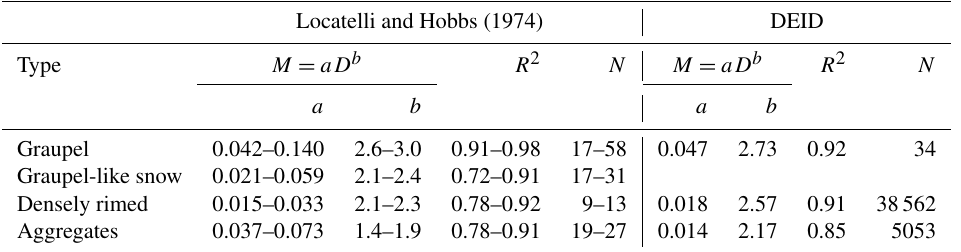
Table 2. Mass–diameter relationship comparison by type.